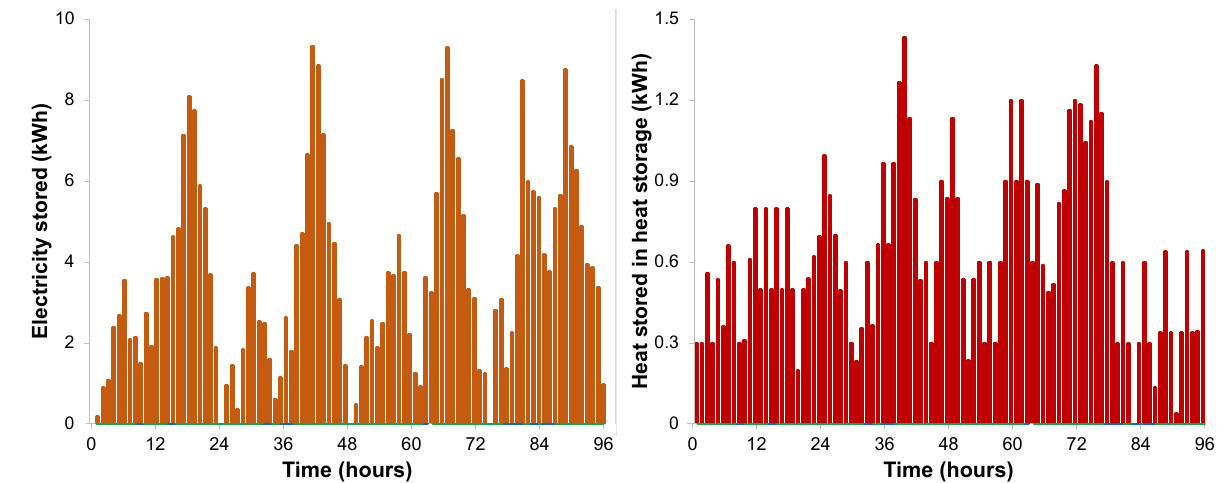
Figure 4. Evolution over the 4-day time horizon of the central electricity and heating storage content, respectively, for household i1.